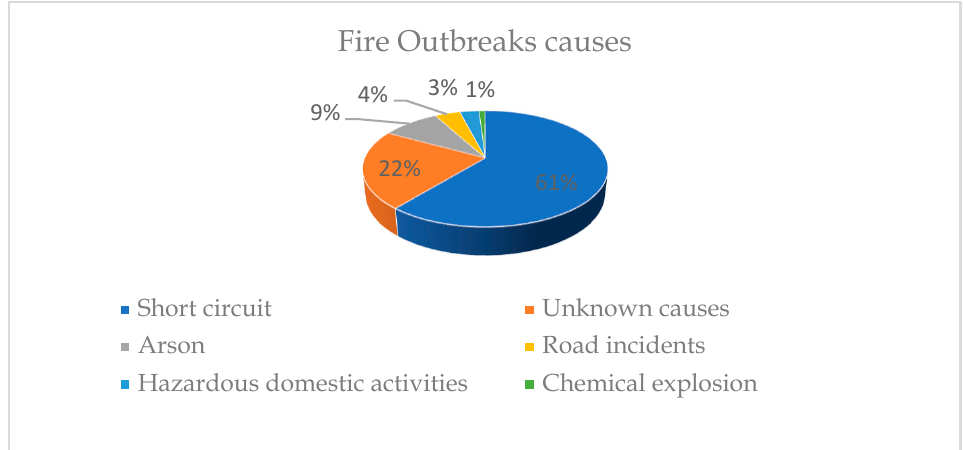
Figure 3. Fire outbreak causes.